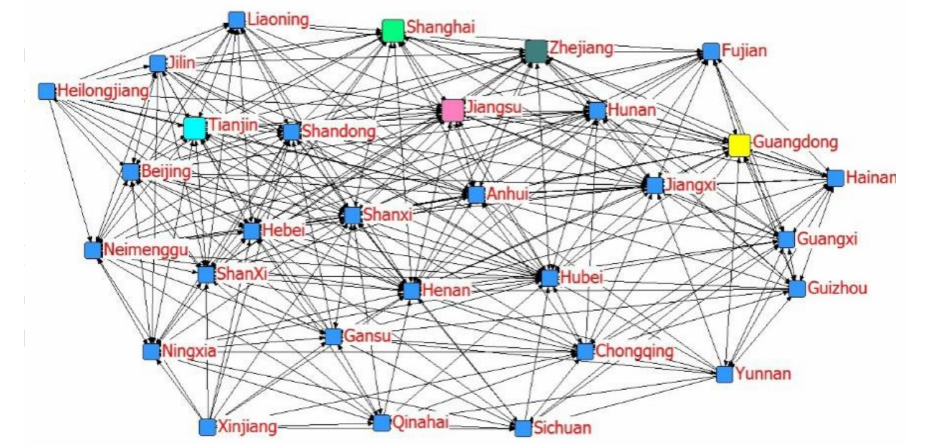
Figure 1. Spatial network diagram of carbon emissions in China’s provinces.